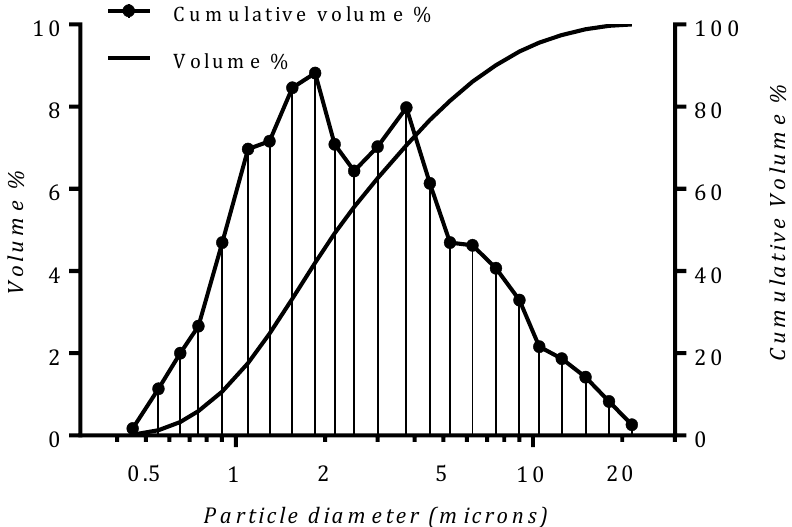
Figure 2. Particle volume size distribution of carbon onion obtained from laser diffraction analysis. All samples have a broad particle size distribution in the range of 0.5 to 21.5 µm. This distribution is slightly bimodal, with two peaks between 1.6 microns and 2 microns and at 3.8 microns and shows a majority of particles with a size between 1 and 5 µm.